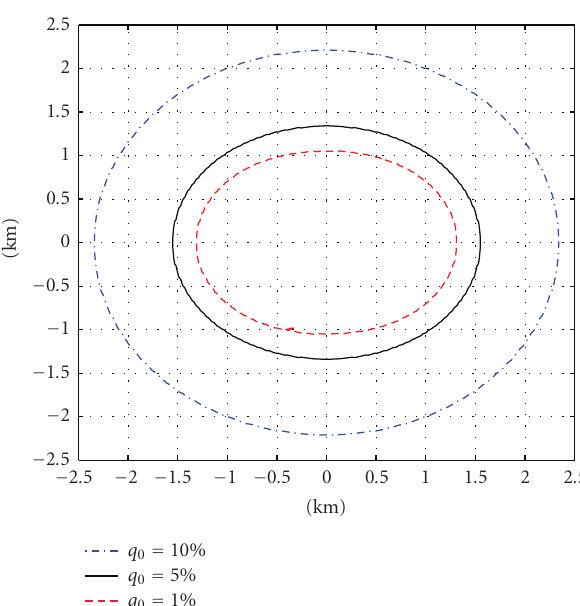
Figure 3: MISO with antenna location (0 . 5,0) and ( − 0 . 5,0).